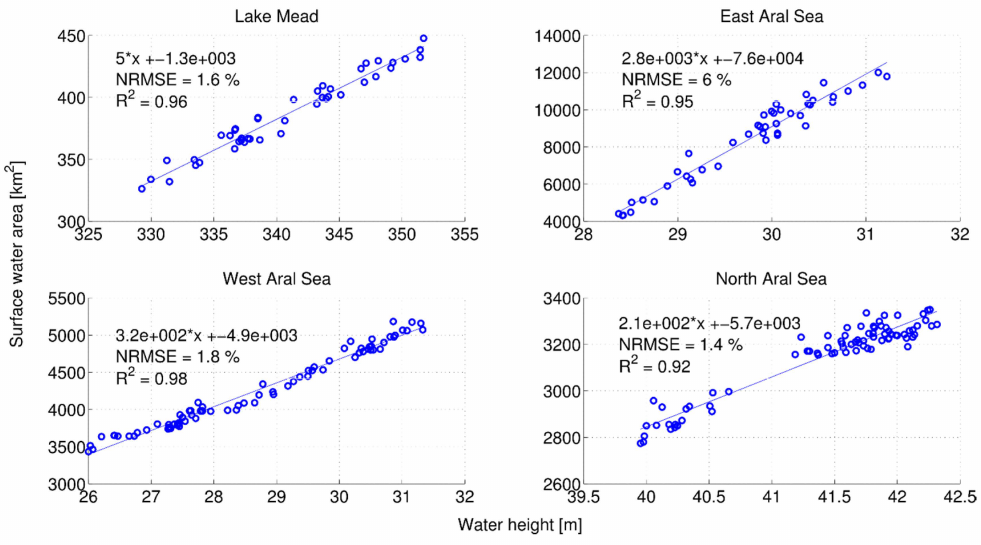
Figure 6. Surface area and water height